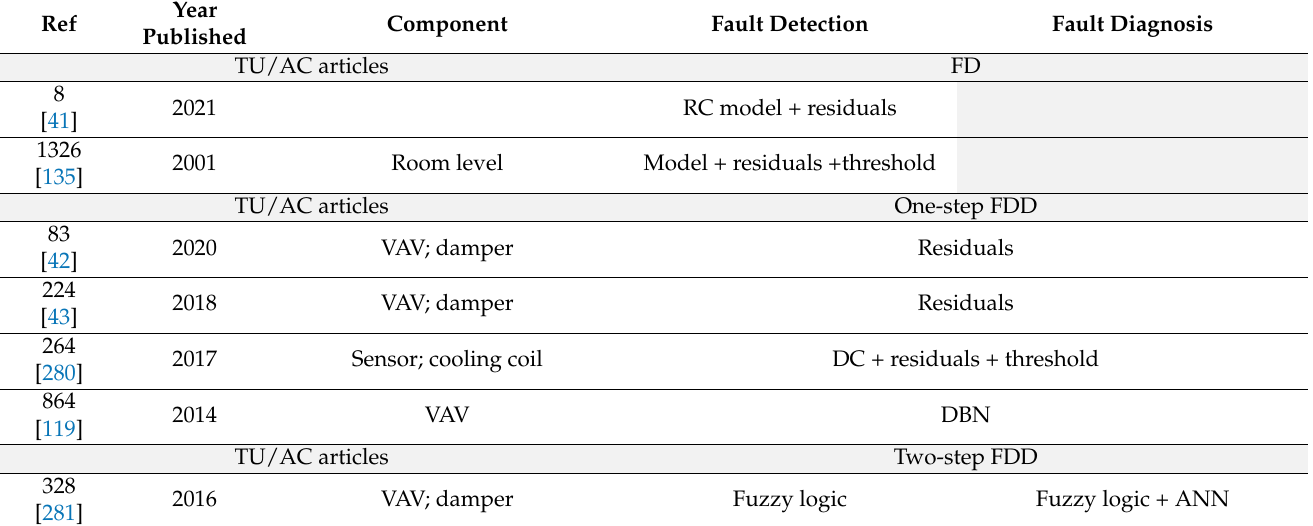
Table A5. Energy distribution: terminal unit/Air-conditioning system.